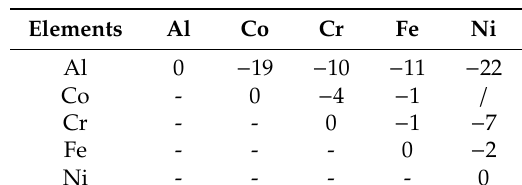
Table 4. The mixing enthalpy ∆ H mix